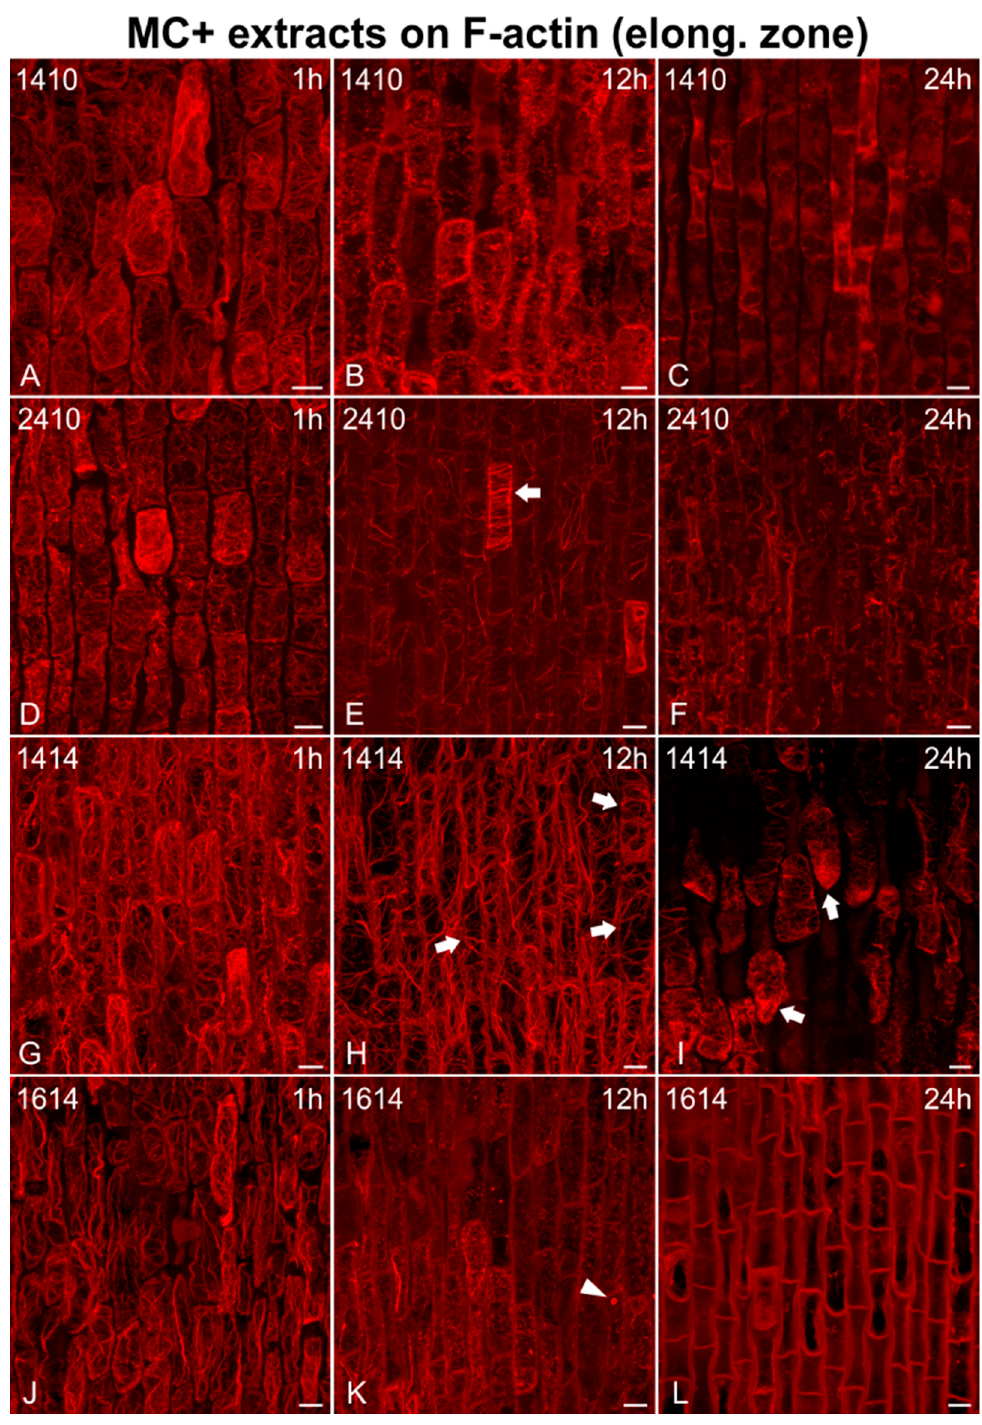
Figure 3. Maximum intensity projections of serial CLSM sections of Oryza sativa epidermal cells in the root elongation zone, stained for F-actin, after treatment with MC+ extracts from various MC- producing strains: Microcystis flos-aquae TAU-MAC 1410 ( A – C ), Microcystis sp. TAU-MAC 2410 ( D – F ), Raphidiopsis raciborskii TAU-MAC 1414 ( G – I ), and Trichormus variabilis TAU-MAC 1614 ( J – L ). Root tips in all images point towards the bottom of the page. After 1 h of treatment ( A , D , G , J ) F-actin network appeared almost unaffected, compared to the control (Figure 1B). After 12 h, actin cables appeared highly affected, being either fragmented ( B ), disoriented (arrows in E , H ), or scarce ( K , note also the actin ring indicated by arrowhead). After 24 h, F-actin either disappeared ( C , L ) or was fragmented ( F ). Actin aggregates could also be detected (arrows in I ). Scale bars: 10 μ m.